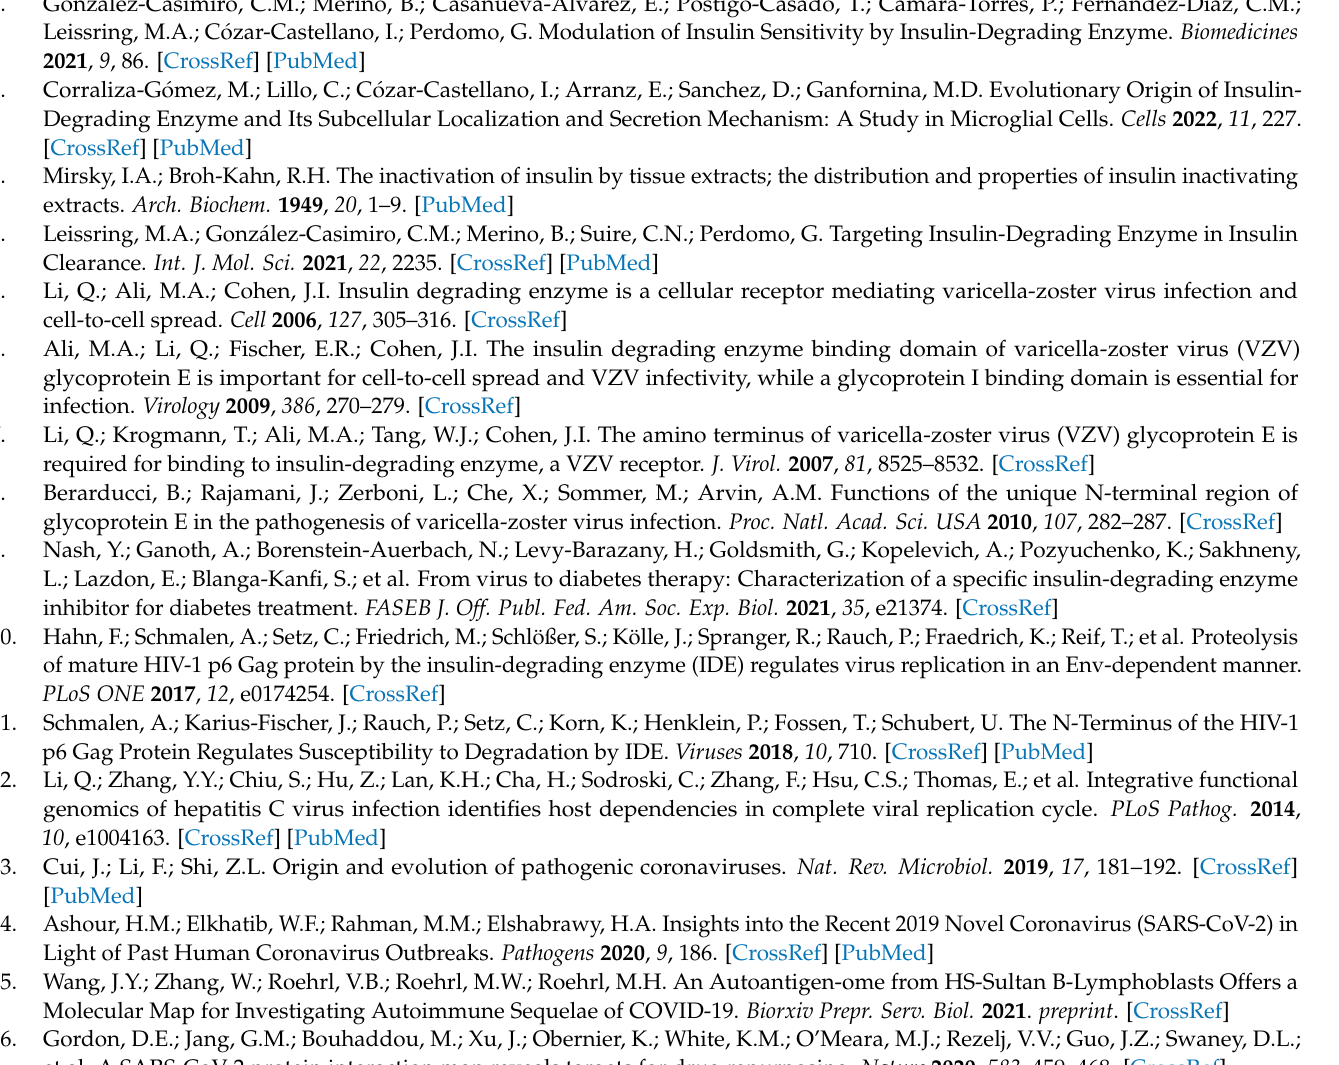
COVID-19 and post-COVID-19 patients. Correlations between triglycerides and monocytes ( A ), CD4 + T-cells ( B ), and CD4 − T-cells ( C ) are shown. The Spearman’s correlation ( ρ ) and statistical significance ( p ) are indicated. Correlations between B-cells and insulin ( D ), glucose ( E ), and triglycerides ( F ) are shown. The R 2 or ρ coefficients and the statistical significance ( p ) are